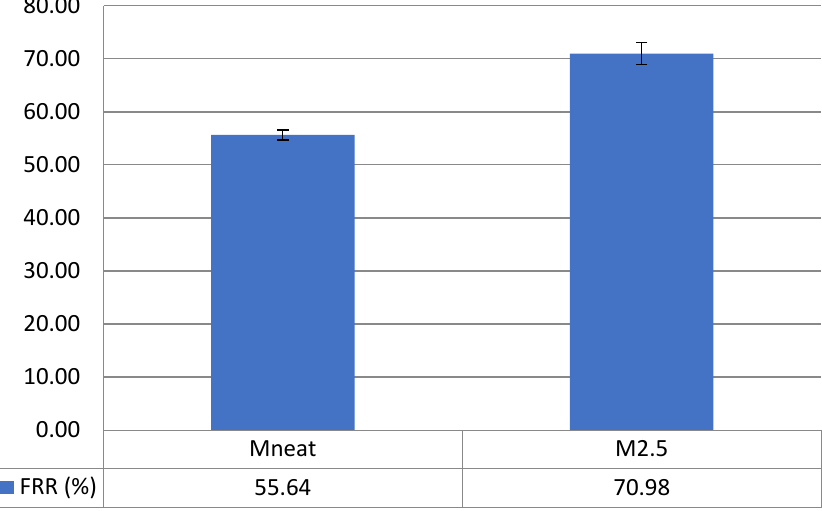
Figure 9. Flux recovery rate of M2.5 AHFM in comparison with MNeat